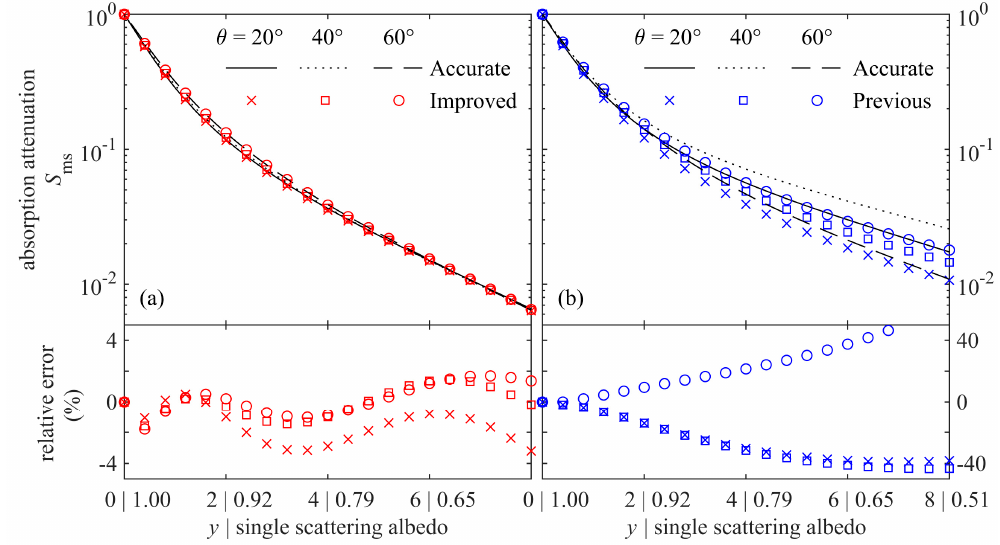
Figure 4. ( a ) The modified function S ms and the relative errors compared to the accurate value from DISORT. The accurate S ms is calculated as (cid:3435)𝑅(cid:3560) (cid:2998) − 𝑅 (cid:2998),(cid:2926)(cid:2918) (cid:3439) (cid:3435)𝑅(cid:3560) (cid:2998)(cid:2868) − 𝑅 (cid:2998),(cid:2926)(cid:2918)(cid:2868) (cid:3439)(cid:3415) , where 𝑅(cid:3560) (cid:2998)(cid:2868) is the truth reflectance of the absorption-free semi-infinite cloud. ( b ) The function S and the relative errors were calculated based on the previous study [32] . The accurate S is calculated as 𝑅(cid:3560) (cid:2998) 𝑅(cid:3560) (cid:2998)(cid:2868) ⁄ . Tests were at three solar zenith angles ( θ ).